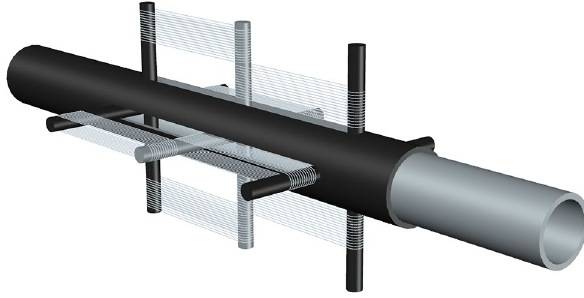
Figure 2. Shape-memory-alloy resisting device